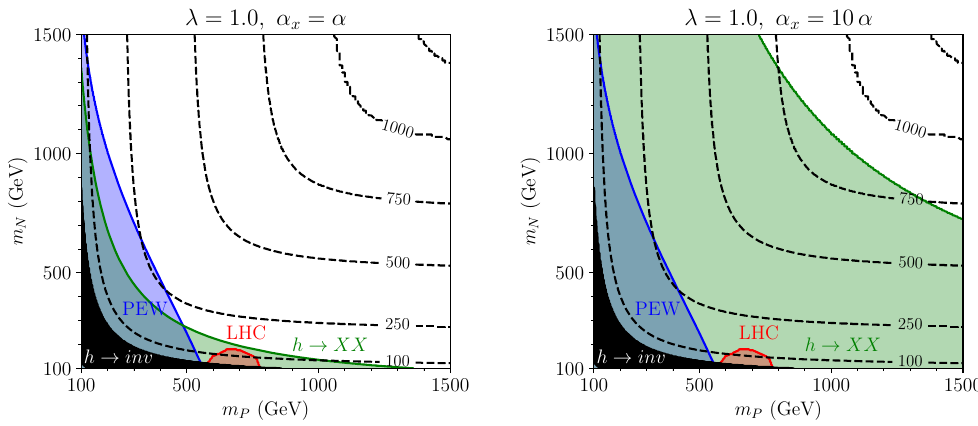
Figure 1 . Laboratory bounds on the connector fermions in the m P – m N plane for λ = 1 . 0 , and α x = α (left) and α x = 10 α (right). The solid black region is excluded by invisible Higgs boson decays ( h → inv ), the shaded green region indicates bounds from h → XX decays, the blue region shows exclusions from precision electroweak tests (PEW), and the red region denotes bounds from direct searches at the LHC. The dashed lines are contours of constant ψ 1 masses m 1 in